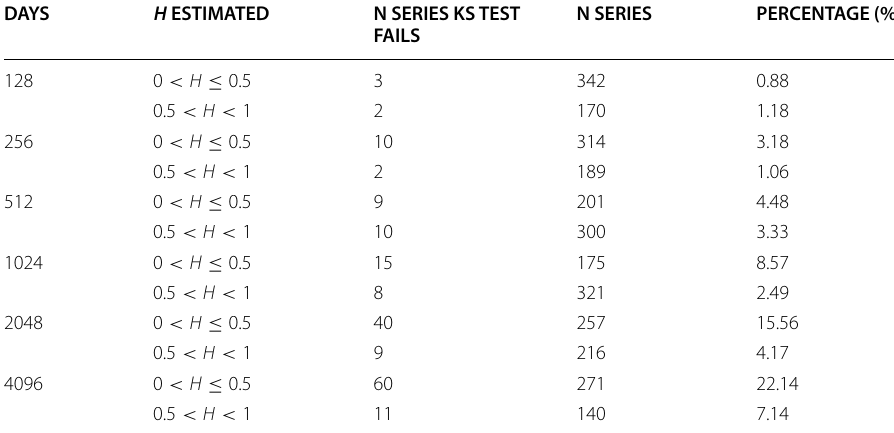
Table 9 Number of series for which any KS test fails and the total number of series with the indicated H DAYS H